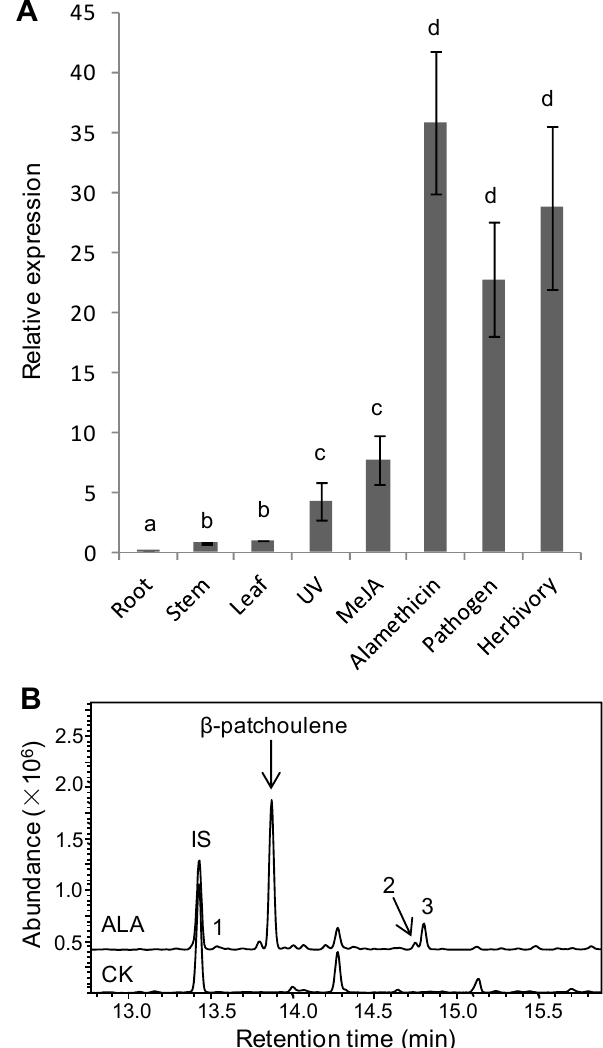
Figure 2. Inducible gene expression of TaPS and β -patchoulene accumulation in wheat. ( A ) qRT-PCR analysis of TaPS in wheat treated with various elicitations including UV irradiation, 50 µ M methyl jasmonate (MeJA), 5 mg / L alamethicin, pathogen infection with F. graminearum spore inoculation or herbivory with beet armyworm larvae feeding. Untreated wheat leaves were used as the control. Relative gene expression level of TaPS in roots and stems were also shown. Gene expression of TaPS was normalized with wheat Actin , the endogenous control gene. Error bars indicate SE ( n = 3). Different lowercase letters indicate significant difference (Tukey HSD test, p < 0.05). ( B ) GC-MS chromatograms of wheat leaf extracts with alamethicin treatment (ALA). CK is the control wheat leaves without any treatments. The induced β -patchoulene and three other sesquiterpenes (peak 1–3) were labeled. Mass spectra and putative identification of peak 1–3 were shown in Figure S2. IS indicates the internal standard.